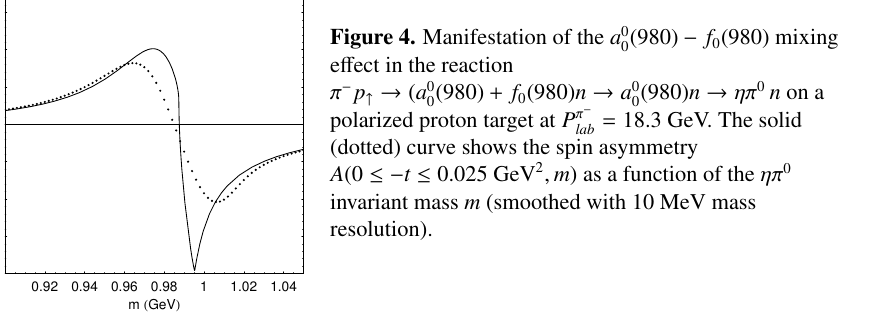
Figure 4. Manifestation of the a 0 (980) − f 0 (980) mixing 0 e ff ect in the reaction π − p ↑ → ( a 0 (980) + f 0 (980) n → a 0 (980) n → ηπ 0 n on a 0 0 = 18 . 3 GeV. The solid polarized proton target at P π − lab (dotted) curve shows the spin asymmetry A (0 ≤ − t ≤ 0 . 025 GeV 2 , m ) as a function of the ηπ 0 invariant mass m (smoothed with 10 MeV mass